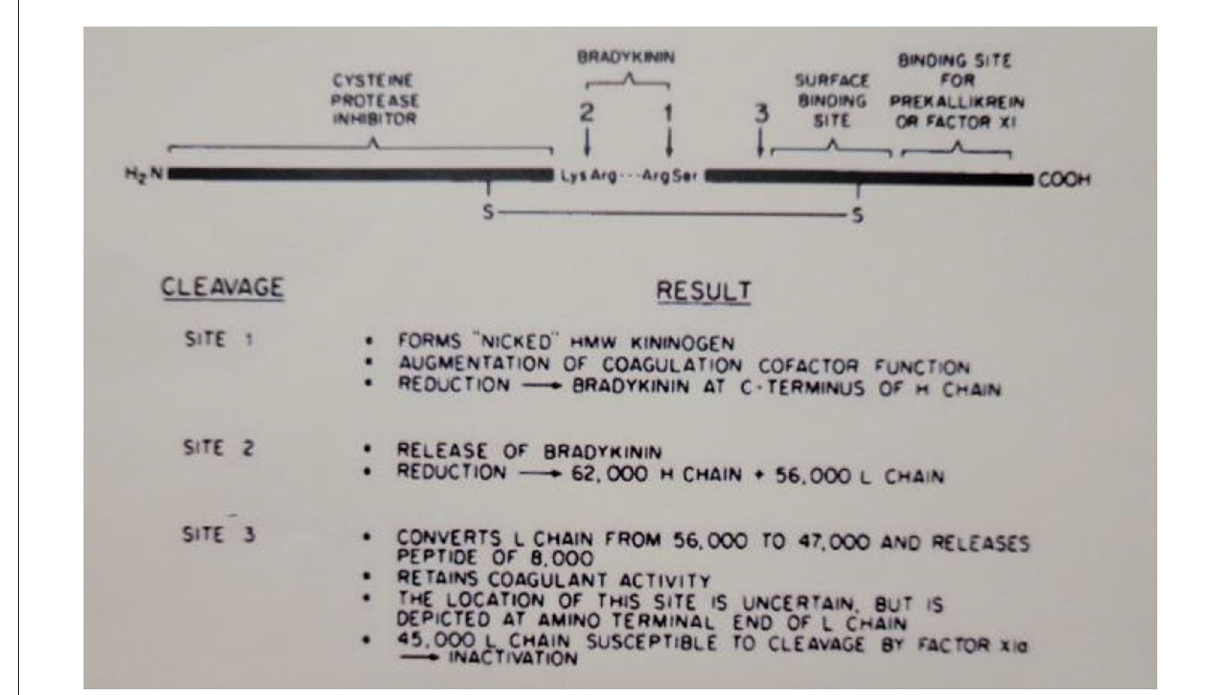
FIGURE3 Depiction of the structure of human HWM kininogen and the consequences of cleavages at the sites indicated. The amino-terminal portion (heavy chain of cleaved kininogen) has the cysteine protease inhibitor activation. The light chain of cleaved HWM kininogen serves as the cofactor function in coagulation, fibrinolysis, and initiation of bradykinin formation.